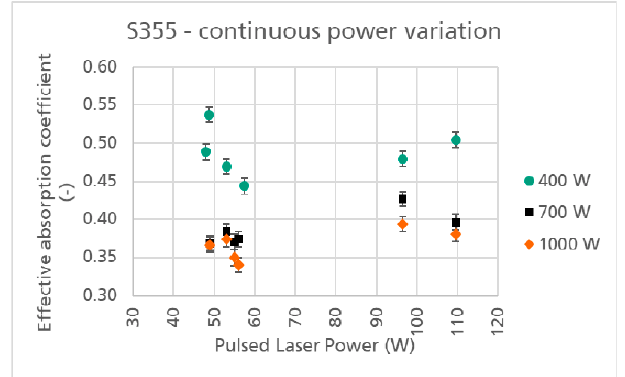
Figure 5. Comparison of the calculated effective absorption coefficients on S355 samples for different continuous wave powers combined with the same pulsed laser parameter sets.